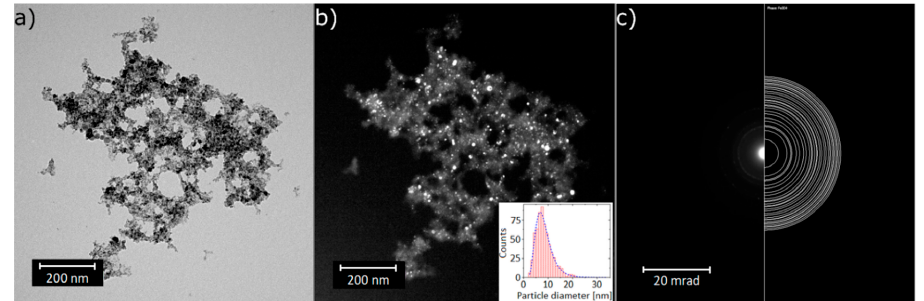
Figure 6. Transmission electron microscope (TEM) images of the powder waste particles recorded in ( a ) a bright field and ( b ) a dark field, ( c ) left part: electron diffraction pattern from the area shown in ( a ) a bright field and ( b ) a dark field, ( c ) left part: electron di ff raction pattern from the area shown in ( a ), ( a ), right part: theoretical diffraction rings for the magnetite phase. right part: theoretical di ff raction rings for the magnetite